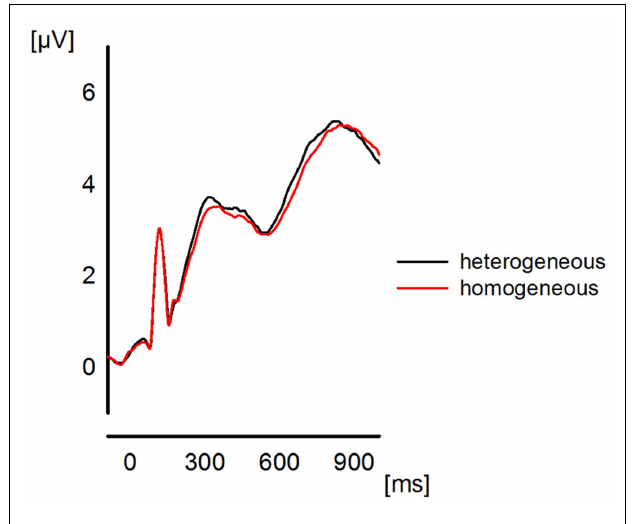
FIGURE 1 |The plot represents the global field power for the ERPs (grand average over all participants) elicited in the two blocking conditions collapsed across the last four presentations. The plot is to show the quality of the ERP data which entered the frequency